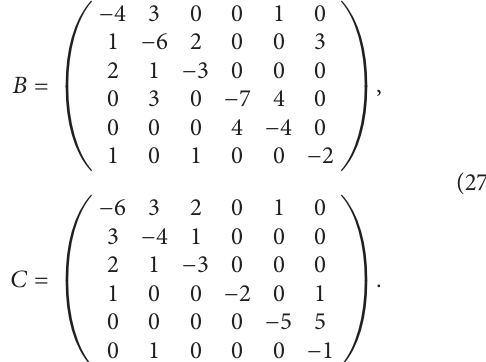
nonlinearly coupled complex networks is effective in all the theorems and